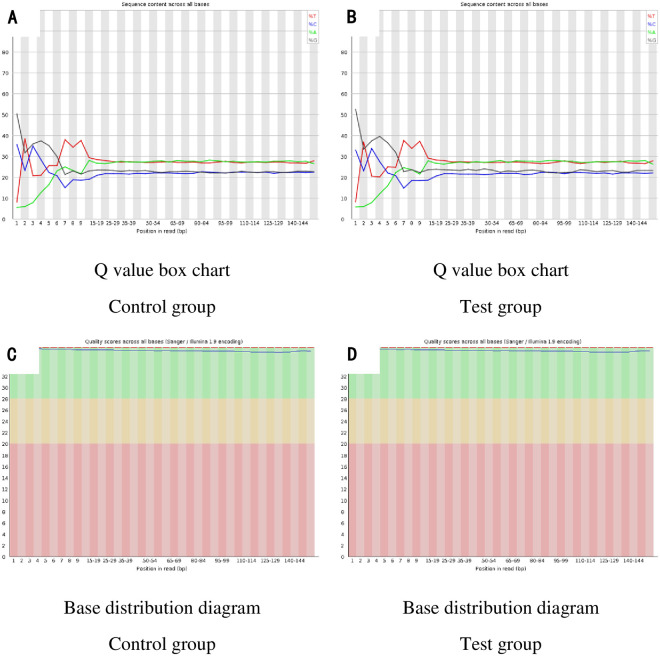
The basic information of data.(3A): Q value box chart of Control group; (3B): Q value box chart of Test group; (3C): Base distribution diagram of Control group; (3D): Base distribution diagram of Test group.